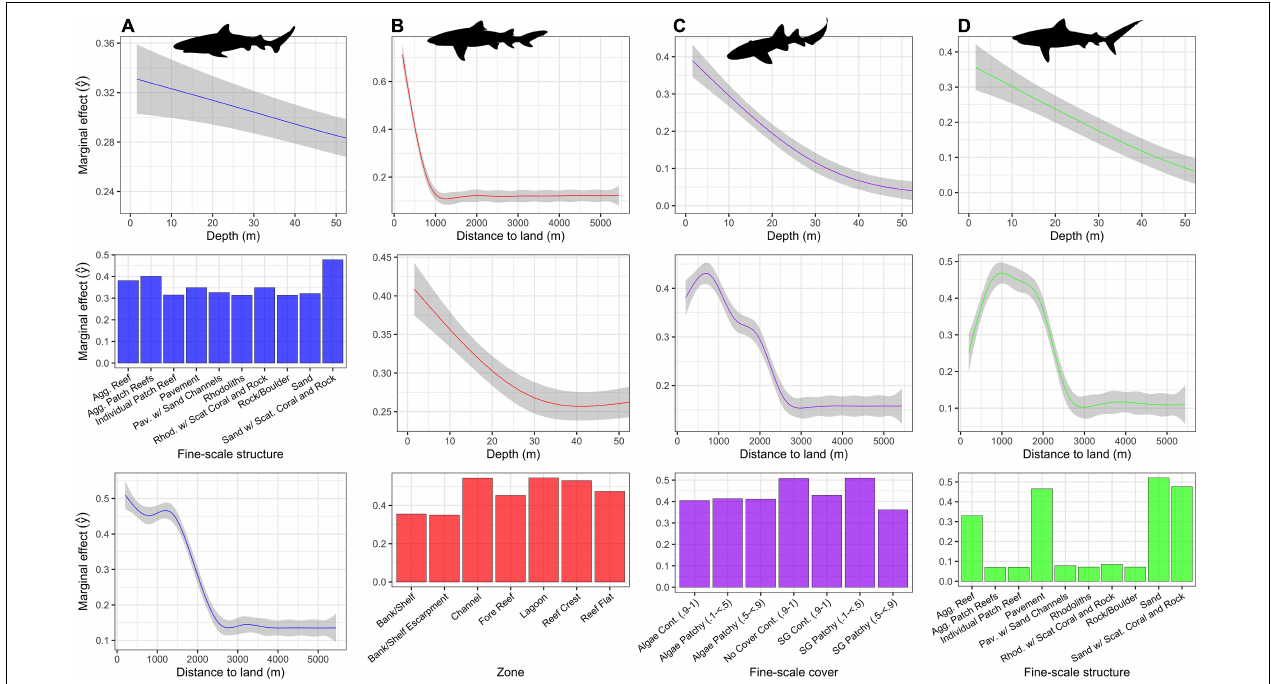
FIGURE 3 | Random forest partial dependency (marginal effects, ˆy) plots for the top three most important (ordered from top to bottom) predictors for (A) Caribbean reef sharks, (B) lemon sharks, (C) nurse sharks, and (D) tiger sharks. The marginal effects indicate the relative selection strength for the given variable with greater ˆy values indicating high relative selection probabilities and lesser values indicating low relative selection probabilities. Discrete predictors are displayed with bar plots and continuous predictors are displayed using a generalized additive model smoother with 95% confidence intervals. Partial dependency plots involving depth were restricted to 50 m depth for each